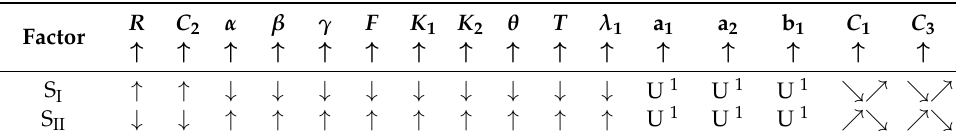
Table 4. The impact of factor change on the system evolution result.